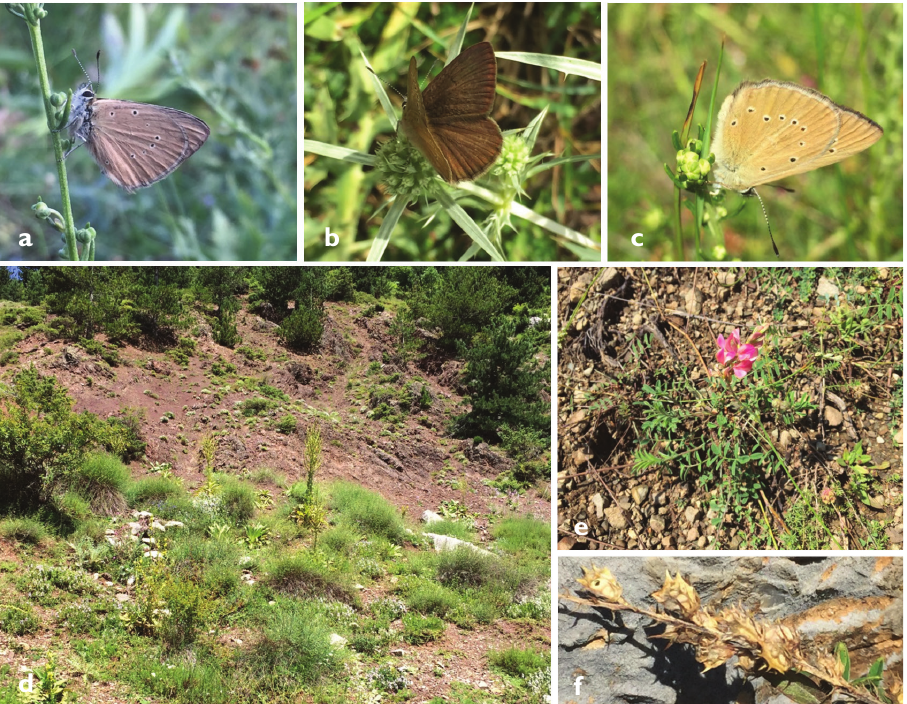
Figure 1. Biotope and specimens in their natural biotopes at the Lurë region a P. lurae sp. nov uns. (sample code 18-115-K71), Albania, Dibër prov., Lurë region, 24.VII.2018 in its biotope b P. lurae sp. nov ups., same specimen c Albanian P. orphicus (sample code 18-124-X103) in its biotope on Karst sub- strate, Dibër prov., Lurë region, 25.VII.2018, NW of Cidhën village d typical biotope of P. lurae with dark ophiolitic soil substrate e, f Onobrychis alba , host plant for Polyommatus ( Agrodiaetus ) sp., growing in ophiolitic soil